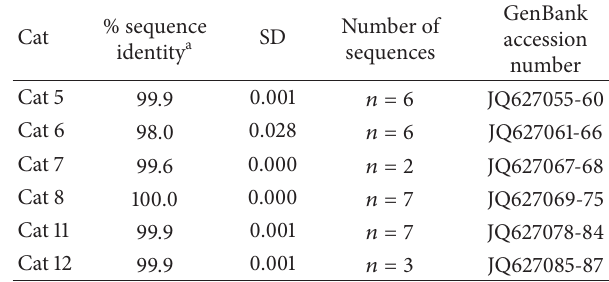
Table 1: Feline coronavirus membrane (M) gene sequence identities (positions from 26293 to 26907 regarding strain FCoV UU47) from different samples of a same cat with